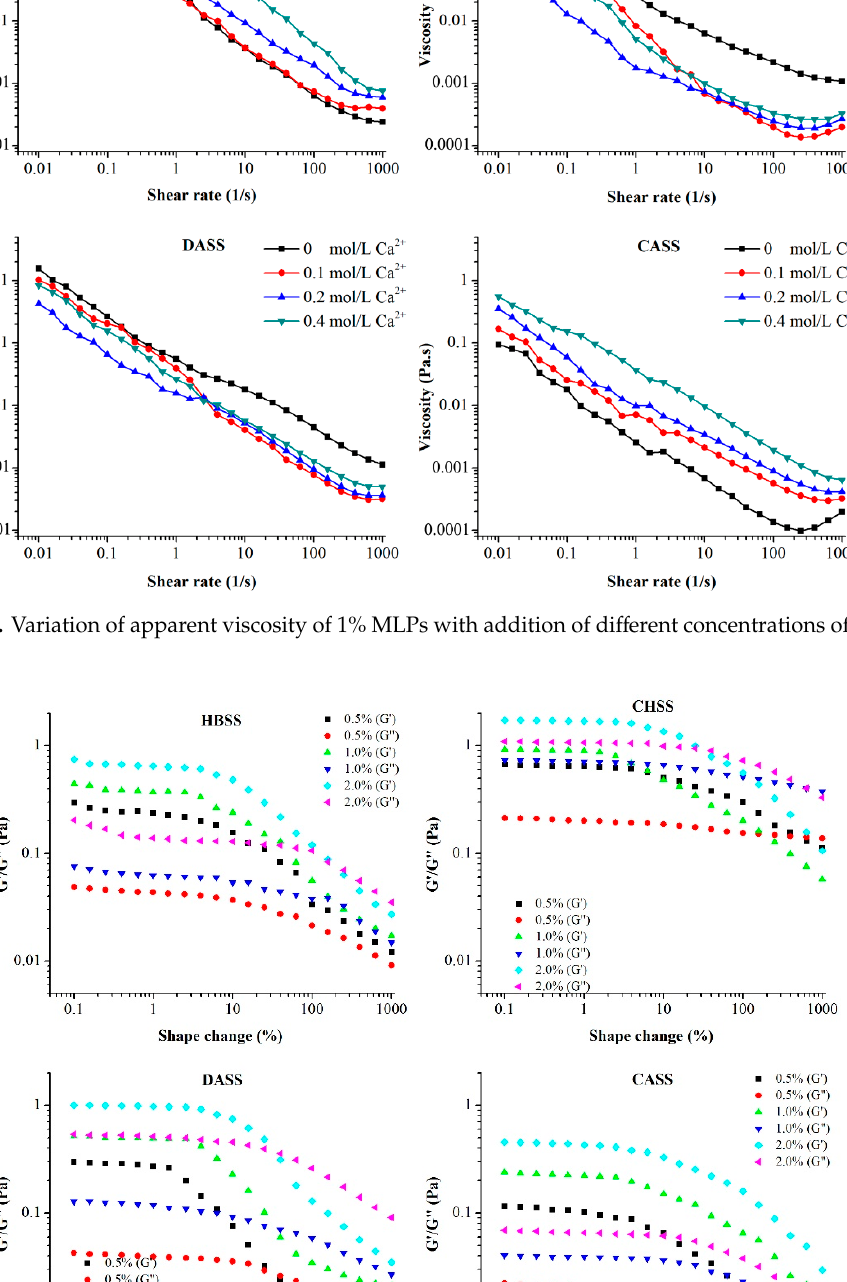
Figure 8. Strain sweeps measurements at 1.0 Hz of MLPs at di ff erent concentrations to determine the G (cid:48) (storage modulus) and G” (loss